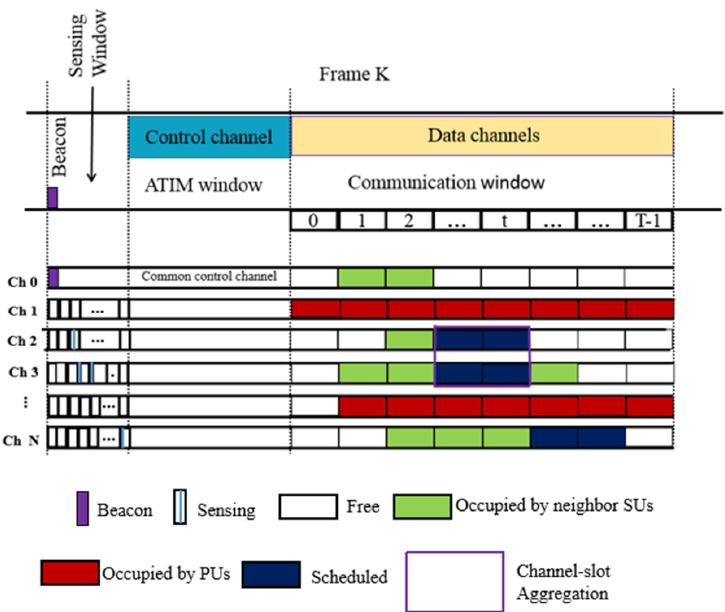
Figure 2. Frame structure of the energy-efficient cognitive radio medium access control (MAC) protocol for battlefield communications. PUs, primary users; SUs, secondary users; ATIM, ad hoc traffic indication message.